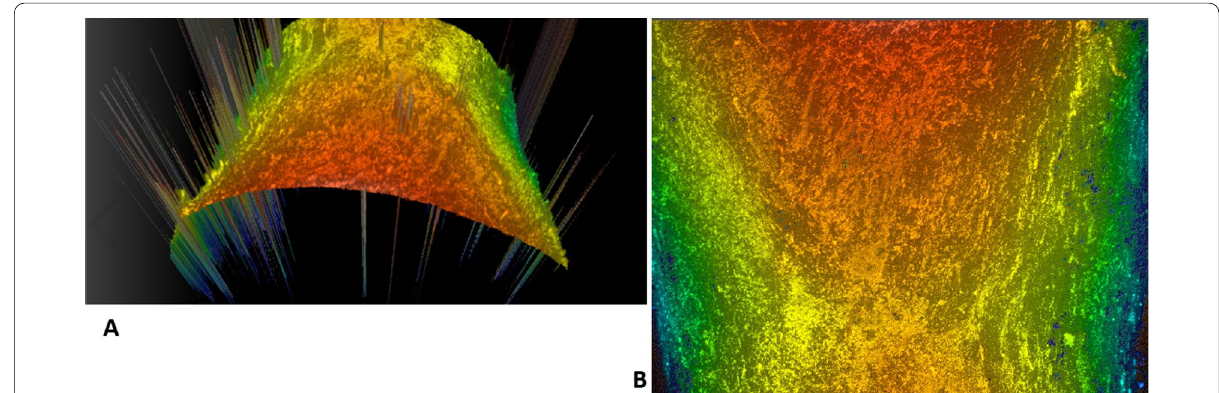
Fig. 3 Example of raw data captured from three‑dimensional confocal microscopy. A Three‑dimensional view, B top‑down view